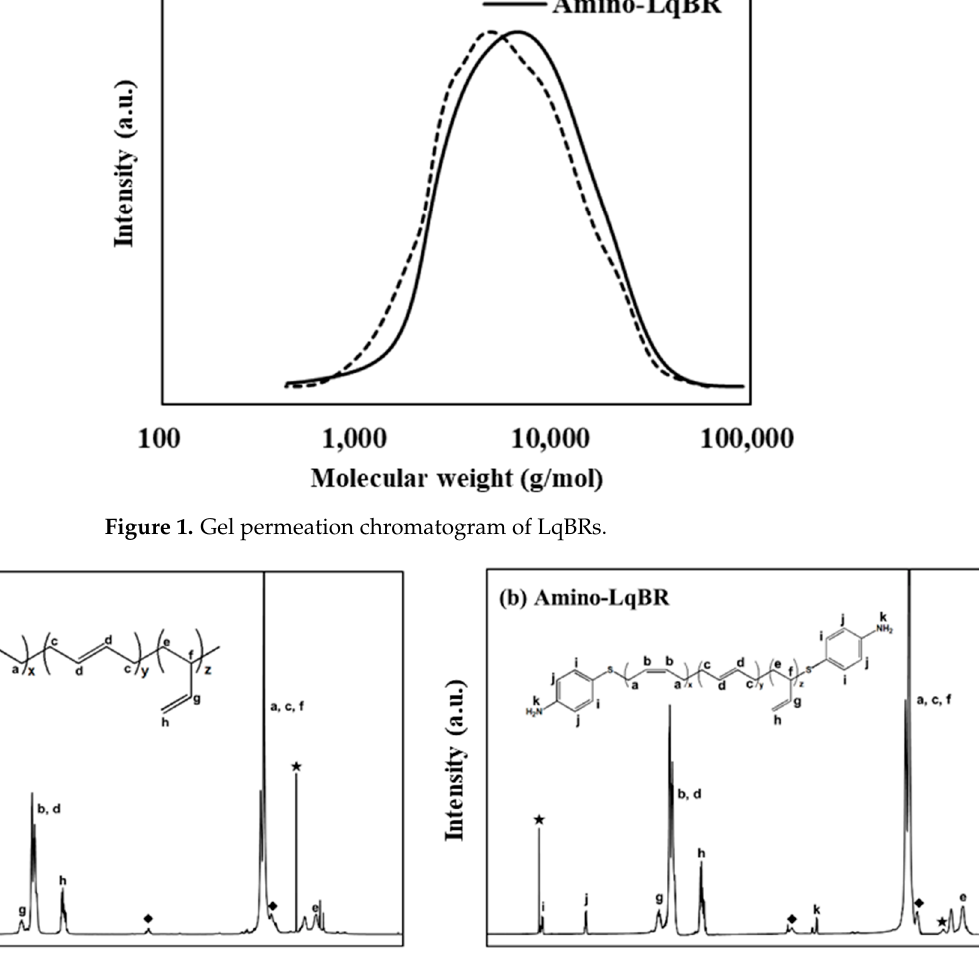
◆ THF solvent). 3 solvent, Figure 2. 1 H NMR spectra; ( a ) N-LqBR; ( b ) amino-LqBR ( ★ CDCl 3 solvent,